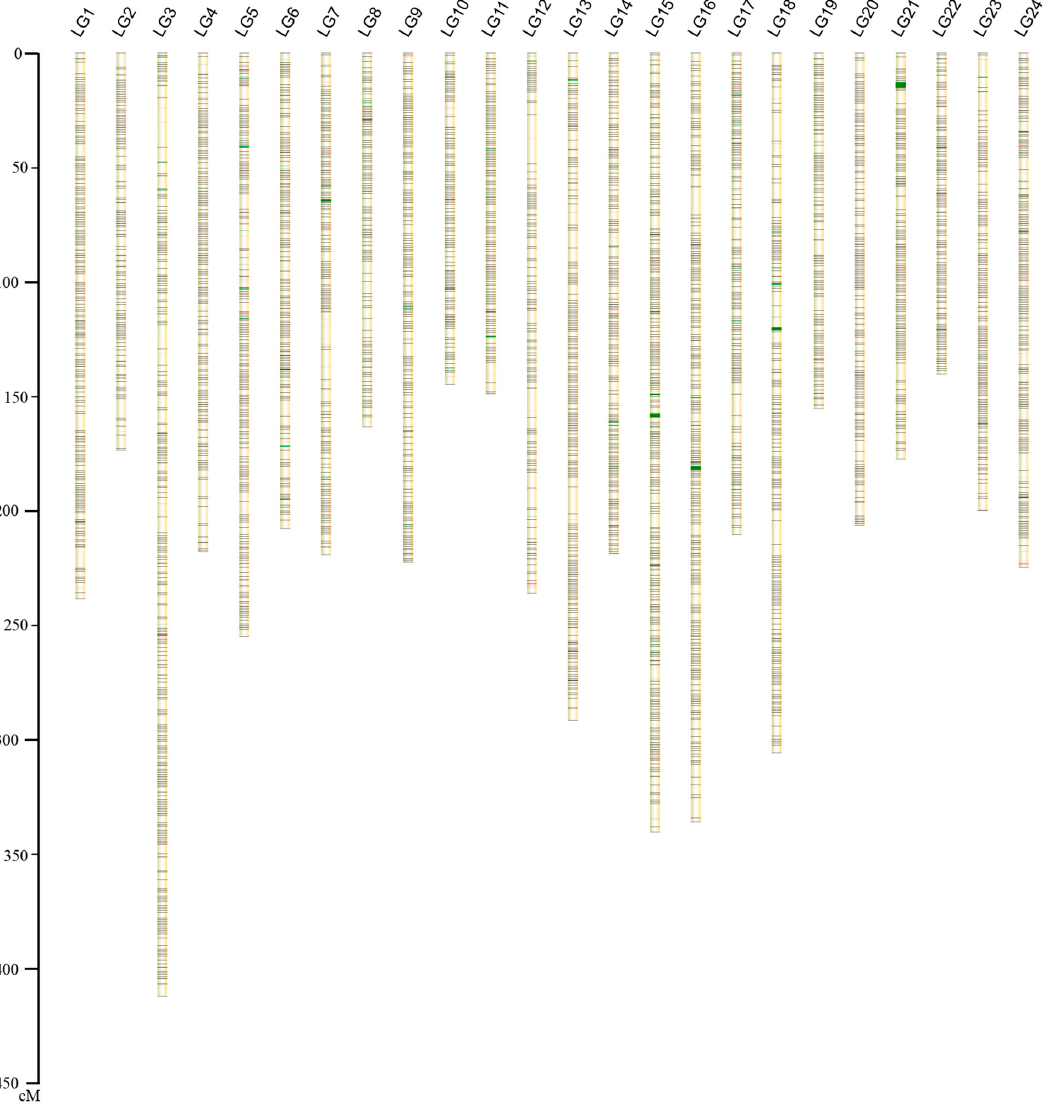
Figure 1. Linkage group lengths, genes involved in immunity and hypoxia adaptation, and marker distribution of the high-density SNP genetic map of large yellow croaker. NOTE: in each group, black lines represent SNPs, red lines represent genes involved in immunity and green lines represent genes involved in hypoxia adaptation. Genetic map details were given in Table S2.